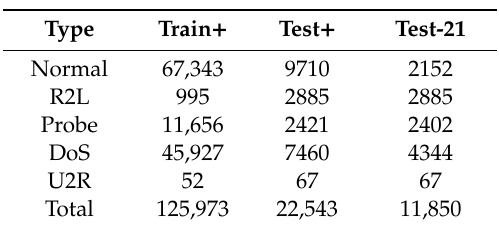
Table 1. NSL-KDD dataset.